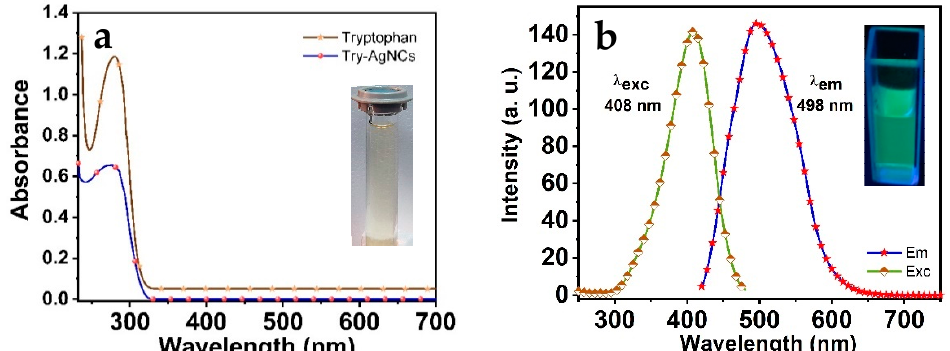
Figure 1. ( a ) The absorption spectra of the tryptophan and Tryp-AgNCs; ( b ) The excitation and emission spectra of Tryp-AgNCs.